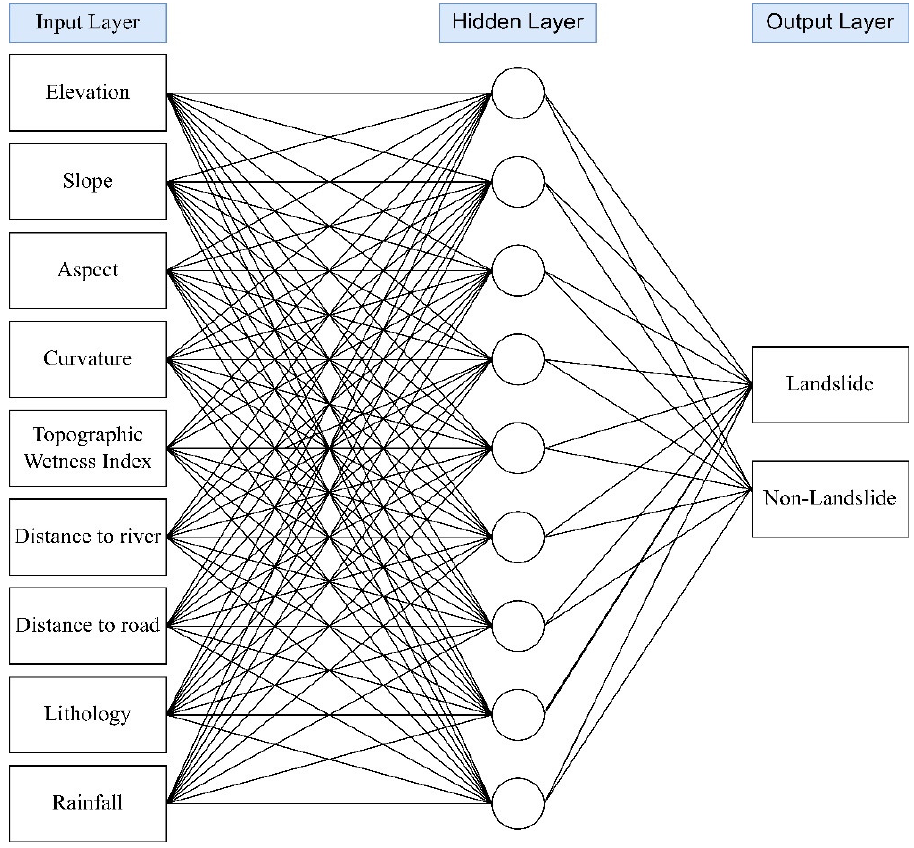
Figure 5. The structure of the Artificial Neural Network (ANN)